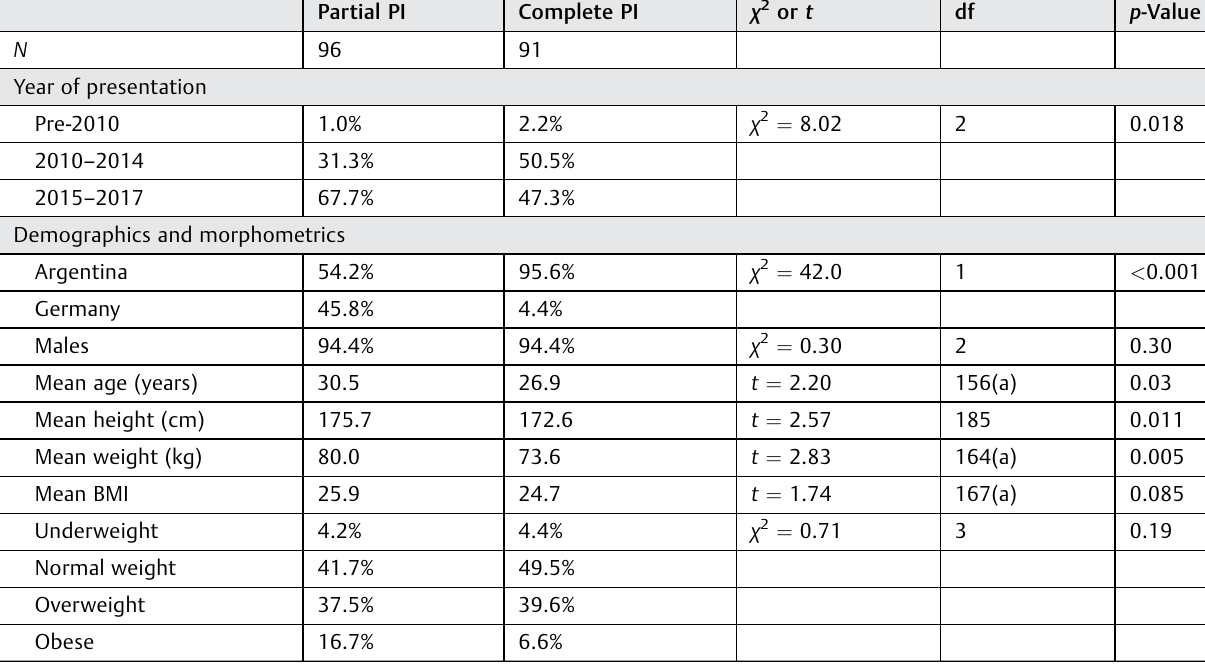
Table 3 Demographics and morphometrics in patients with incomplete versus complete PIs Partial PI